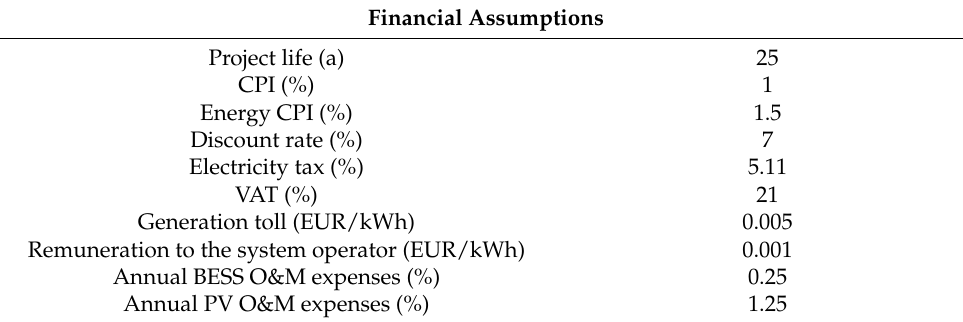
Table 3. Financial parameters assumed in the simulation process.